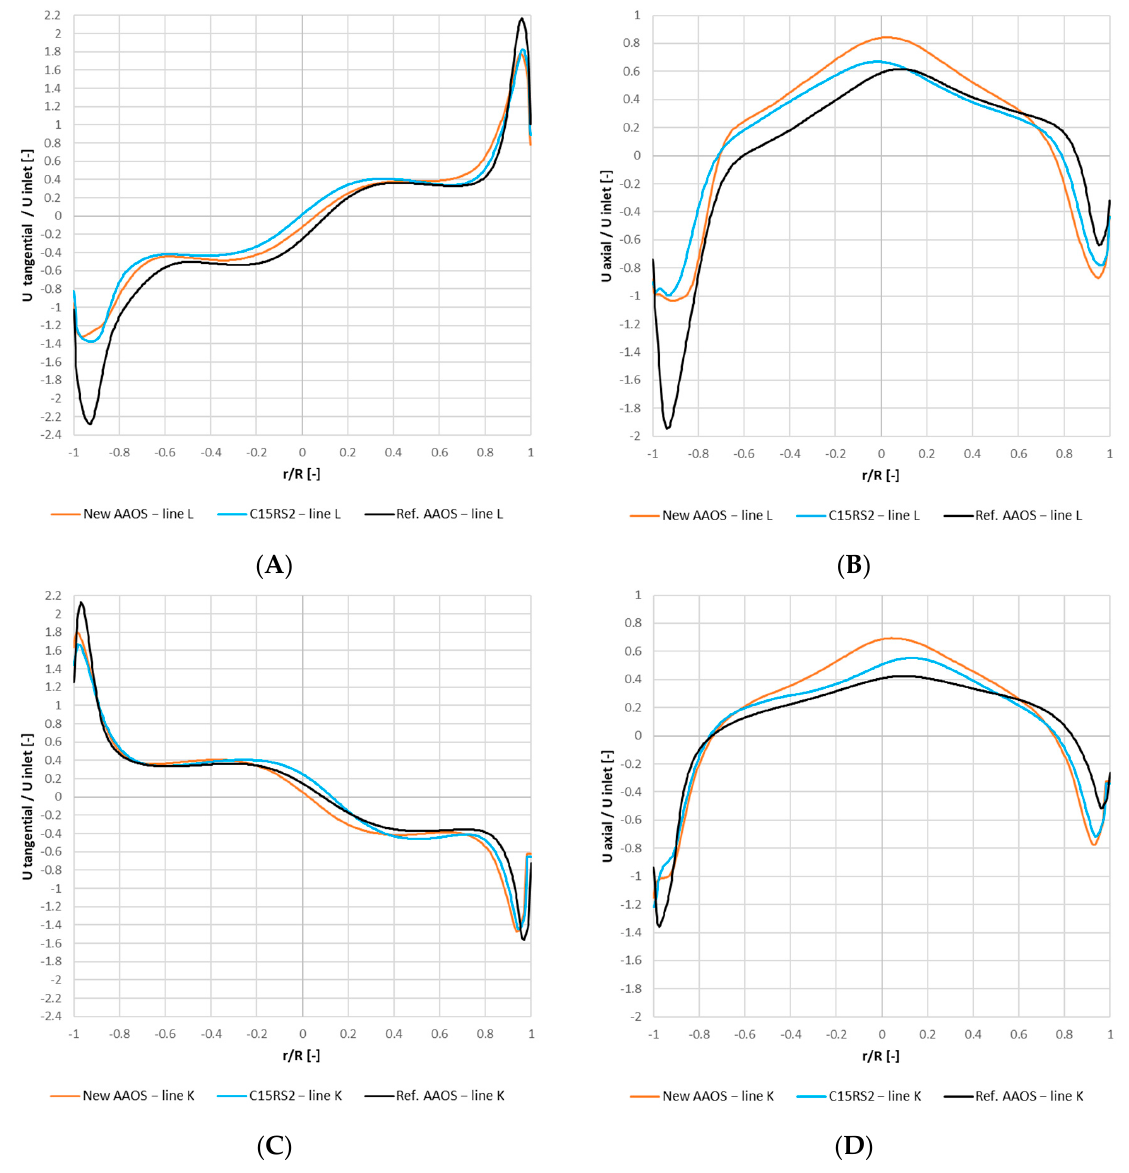
Figure 15. ( A ) tangential velocity at line L; ( B ) axial velocity at line L; ( C ) tangential velocity at line K; ( D ) axial velocity at line K.